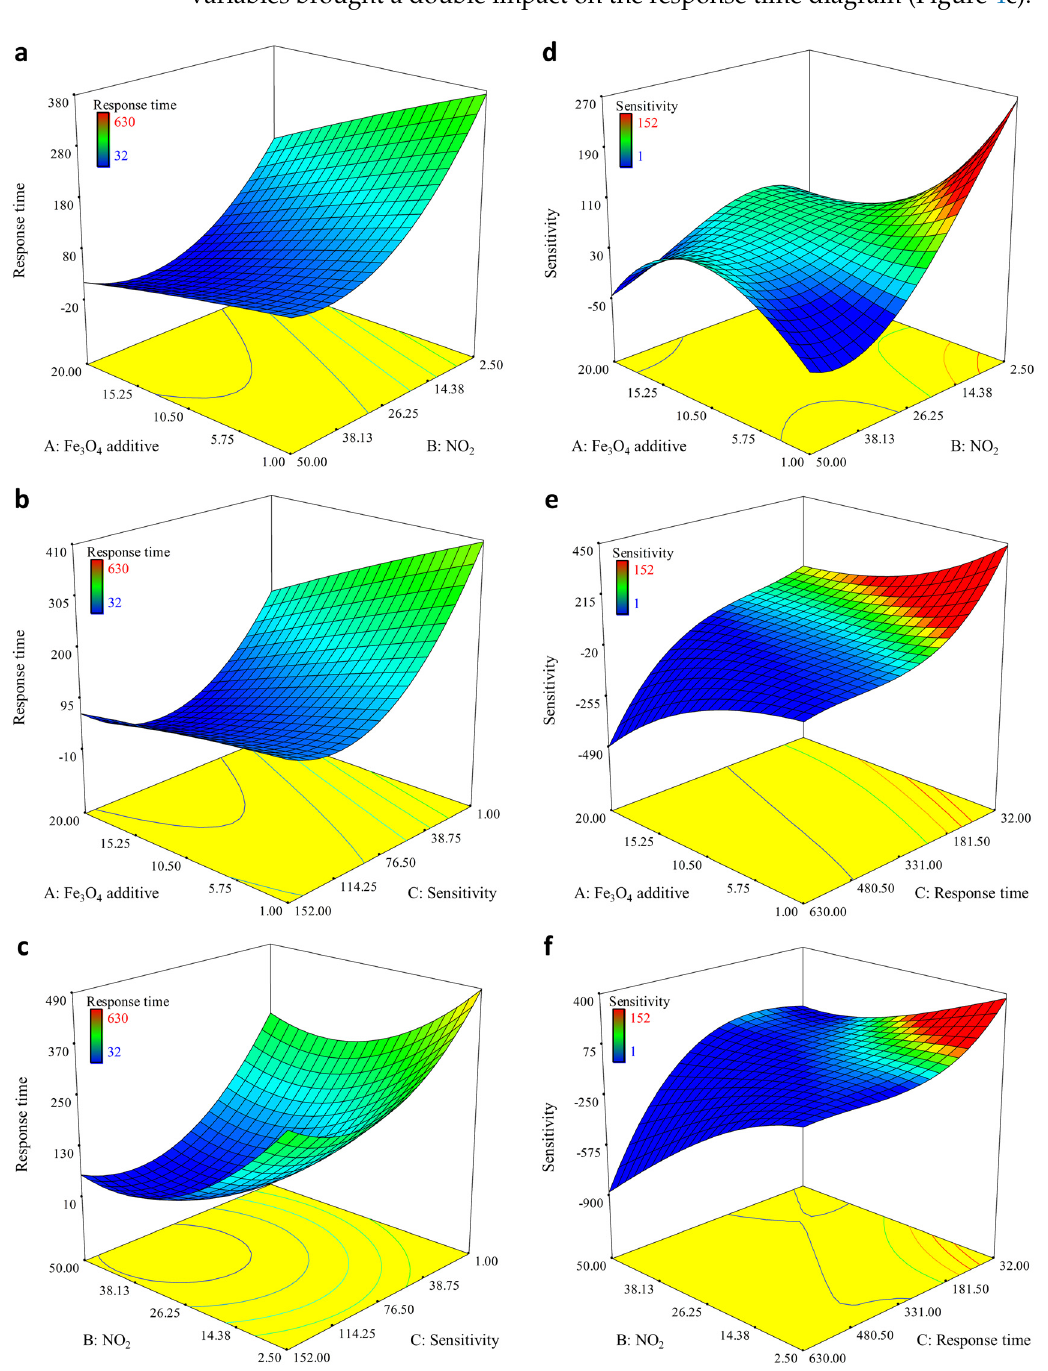
Figure 4. Sensitive analysis of the input data in the optimization model based on response time ( a – c ), and the outputs of dual comparison of the most significant features according to sensitivity ( d – f ).